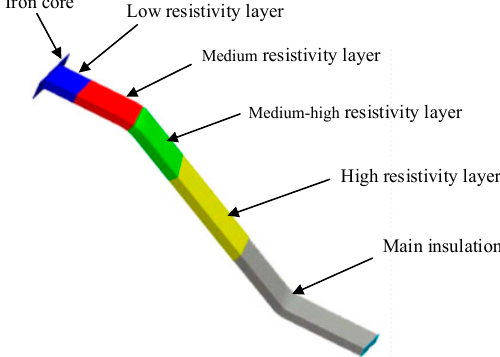
Figure 2. Three-dimensional end model of a stator bar.